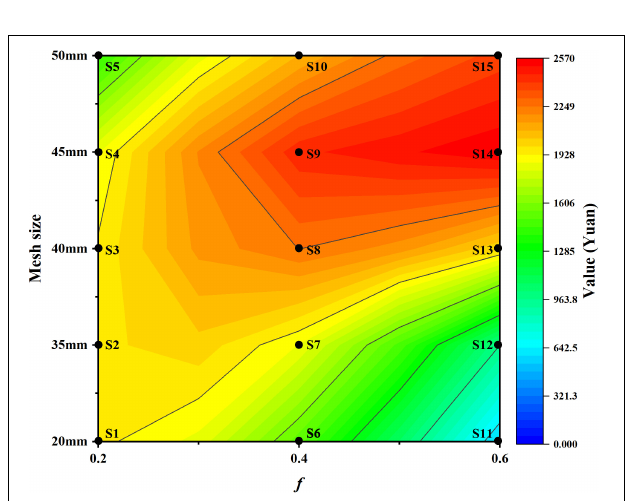
FIGURE 9 | The contour map of economic value in different harvest